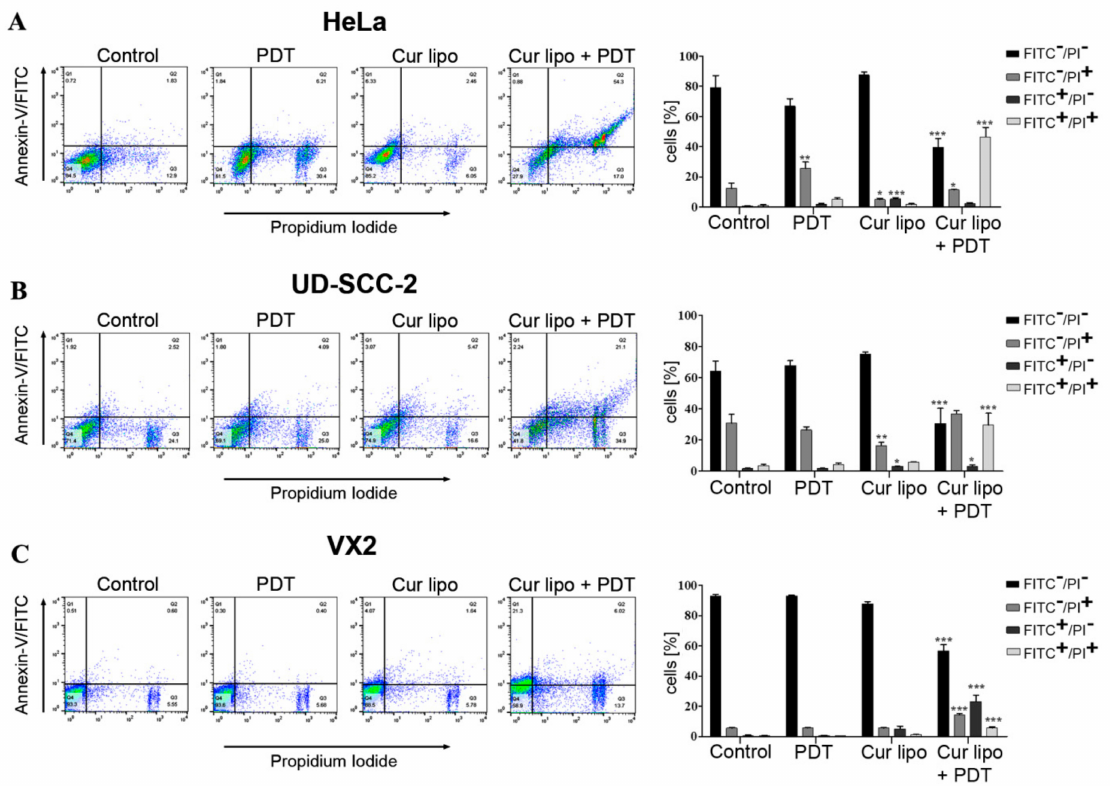
Figure 3. Evaluation of apoptosis as a cause of cell death in HeLa, UD-SCC-2, and VX2 cells after treatment with curcumin liposomes (Cur lipo) and photodynamic therapy (PDT). All cells were incubated with Cur lipo for 4 h and subsequently irradiated with a light fluence of 3 J · cm − 2 . After 24 h treatment, cells were co-stained with Annexin V-FITC (fluorescein isothiocyanate) and PI (propidium iodide). Representative flow cytometry micrographs are shown for HeLa ( A ), UD-SCC-2 ( B ), and VX2 ( C ) cells treated with PDT alone, Cur lipo alone, or a combination of Cur lipo with PDT. Untreated cells were used as a control. Q1 represents early apoptotic cells, Q2 represents late apoptotic or necrotic cells, Q3 represents necrotic cells, and Q4 represents live cells. Bar graphs represent the percentage of total apoptotic cells from at least three experiments. Data are shown as mean ± standard deviation, and statistical significances are indicated as *** p < 0.001, ** p < 0.01, * p <